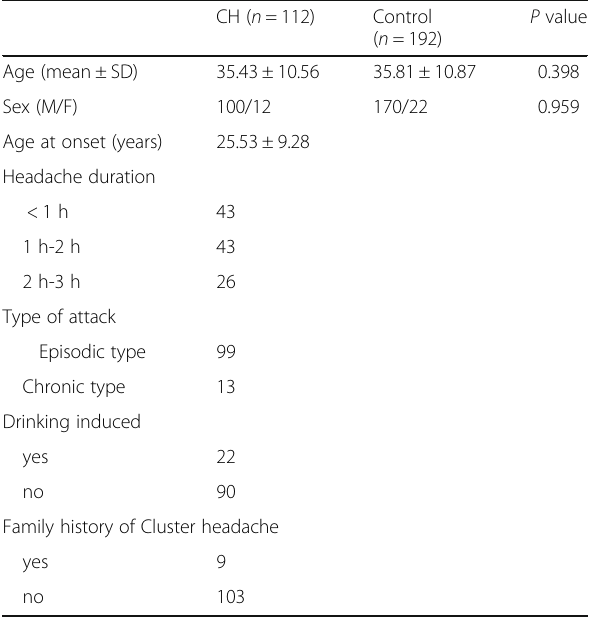
Table 1 Clinical characteristics of the study